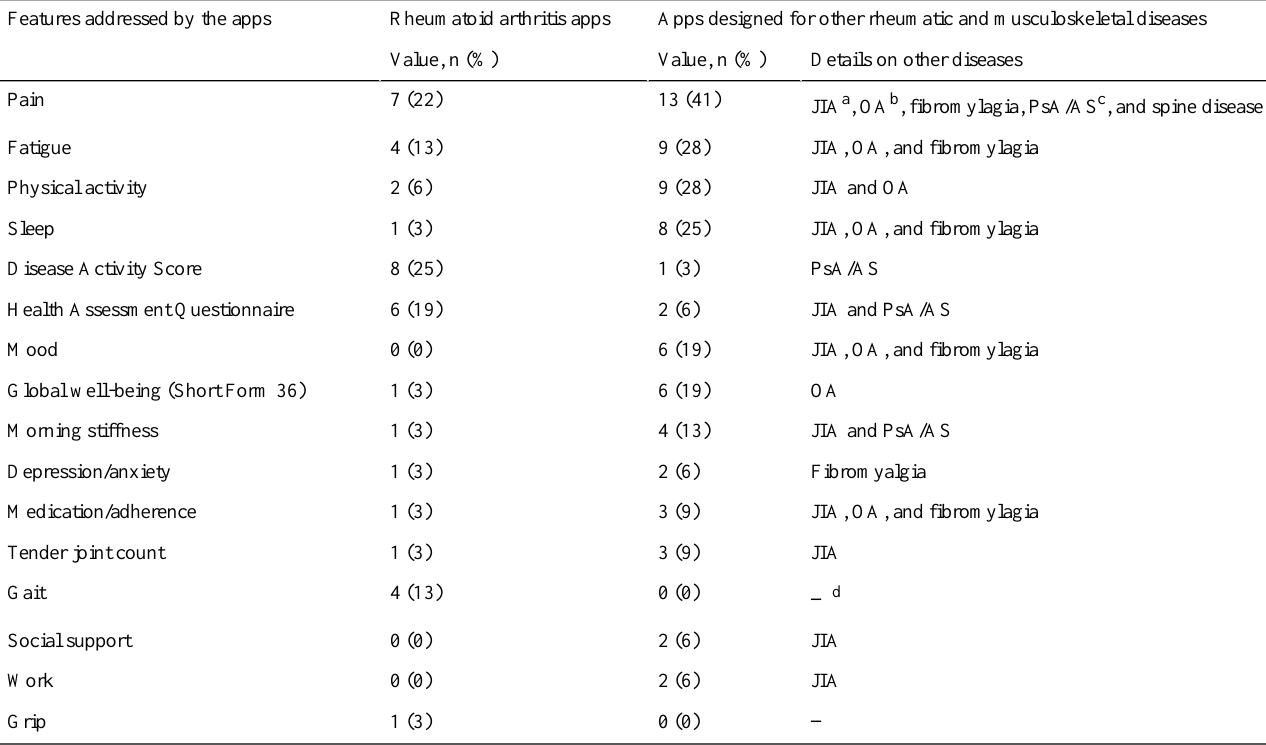
Table 1. Features addressed by the different apps for rheumatoid arthritis and other rheumatic and musculoskeletal